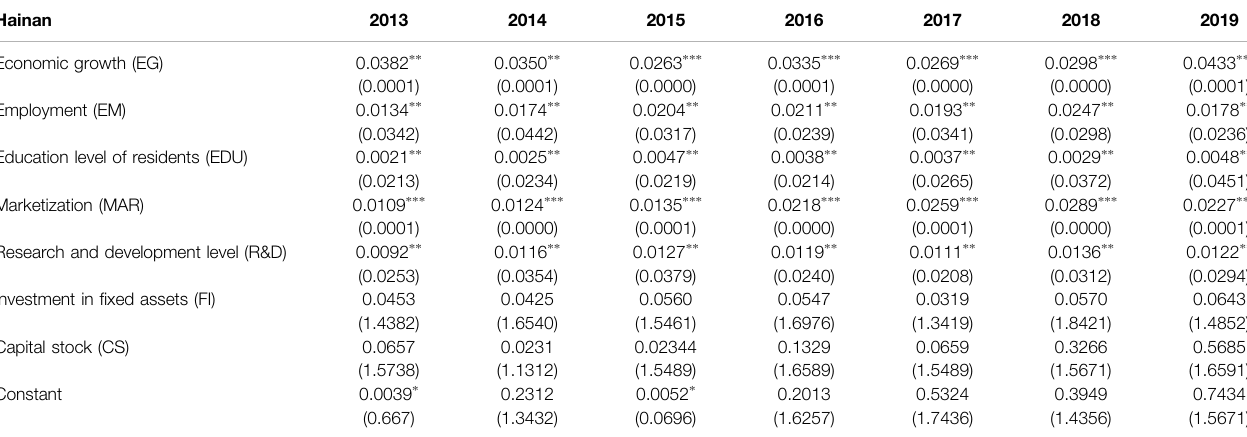
TABLE 15 | Driving force of Hainan health tourism industry convergence development. Hainan